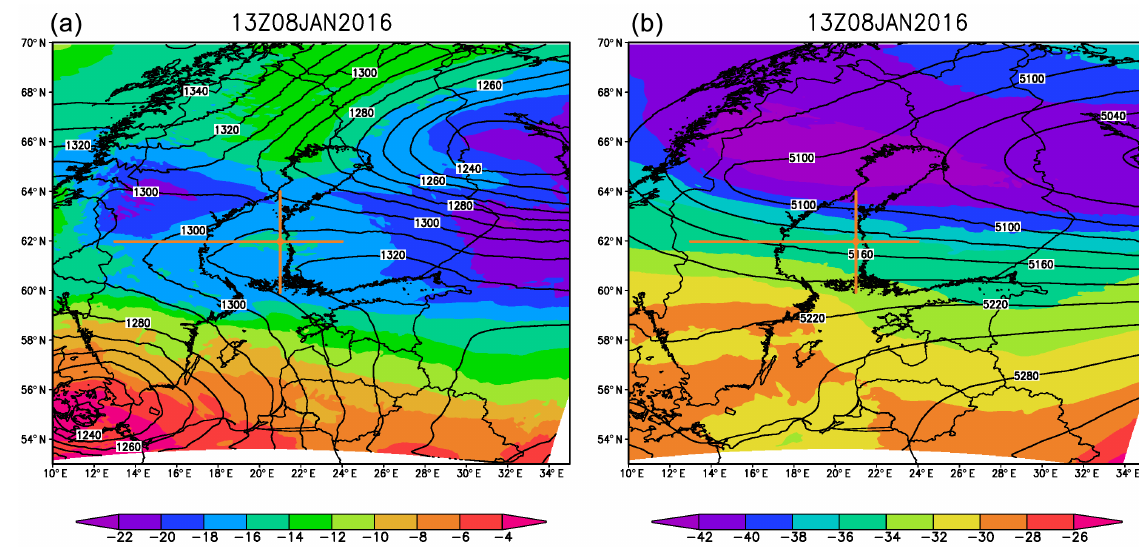
Figure 1. Temperature (in ◦ C, shading) and geopotential height (in m, contours in black) at 850hPa (a) and 500hPa (b) at 13:00UTC on 8 January 2016, as simulated by HARMONIE. The scales of the axes are latitudes and longitudes. The vertical sections in Figs. 4 and 6a are made along the west-east line segment and those in Fig. 6b along the south-north line